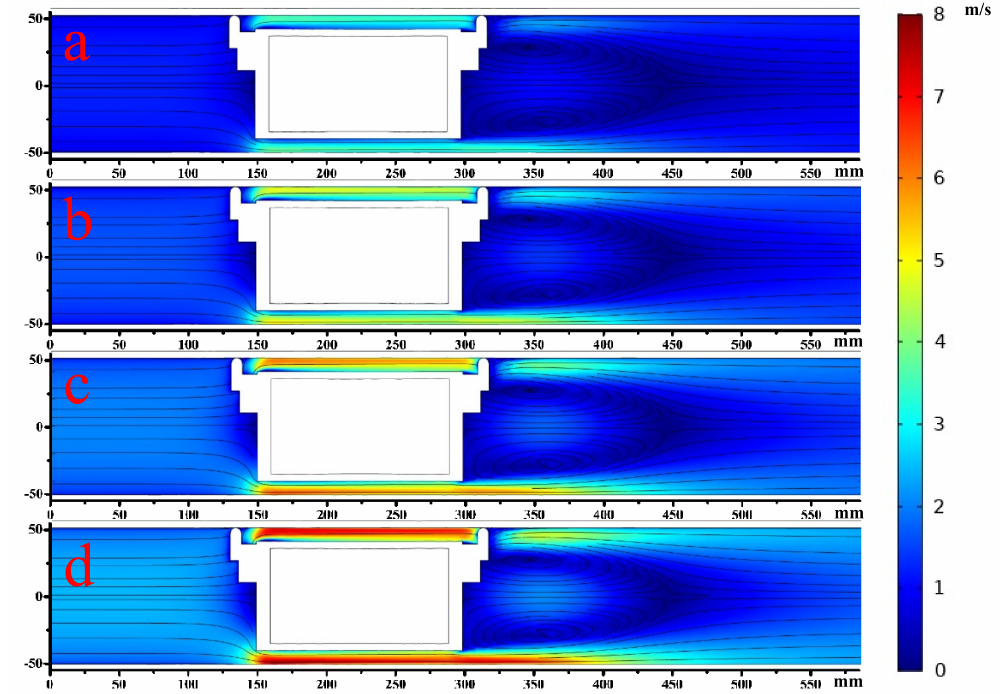
Figure 9. The velocity distribution cloud of the XZ plane of the piped carriage with di ff erent discharge. ( D c × L c = 80 mm × 150 mm) Note: ( a ) Q = 30 m 3 · h − 1 ; ( b ) Q = 40 m 3 · h − 1 ; ( c ) Q = 50 m 3 · h − 1 ; ( d ) Q = 60 m 3 · h − 1 .